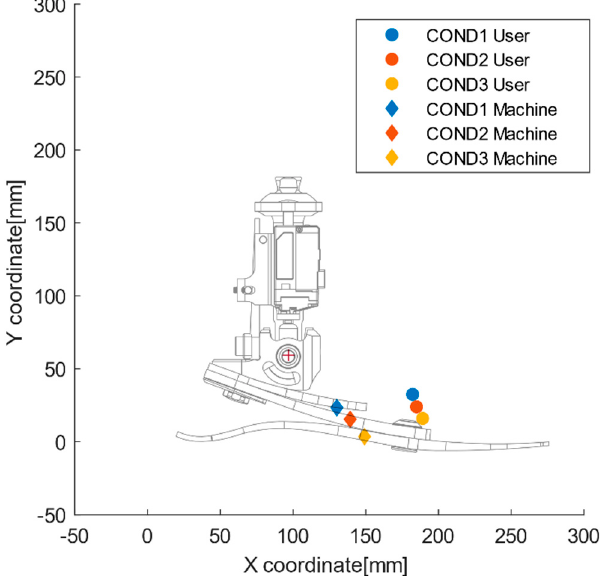
Figure 10. Functional joint center location for three stiffness settings, condition 1 (softest), condition 2 (mid), and condition 3 (stiffest), calculated for machine test and biomechanical tests during level- ground walking.